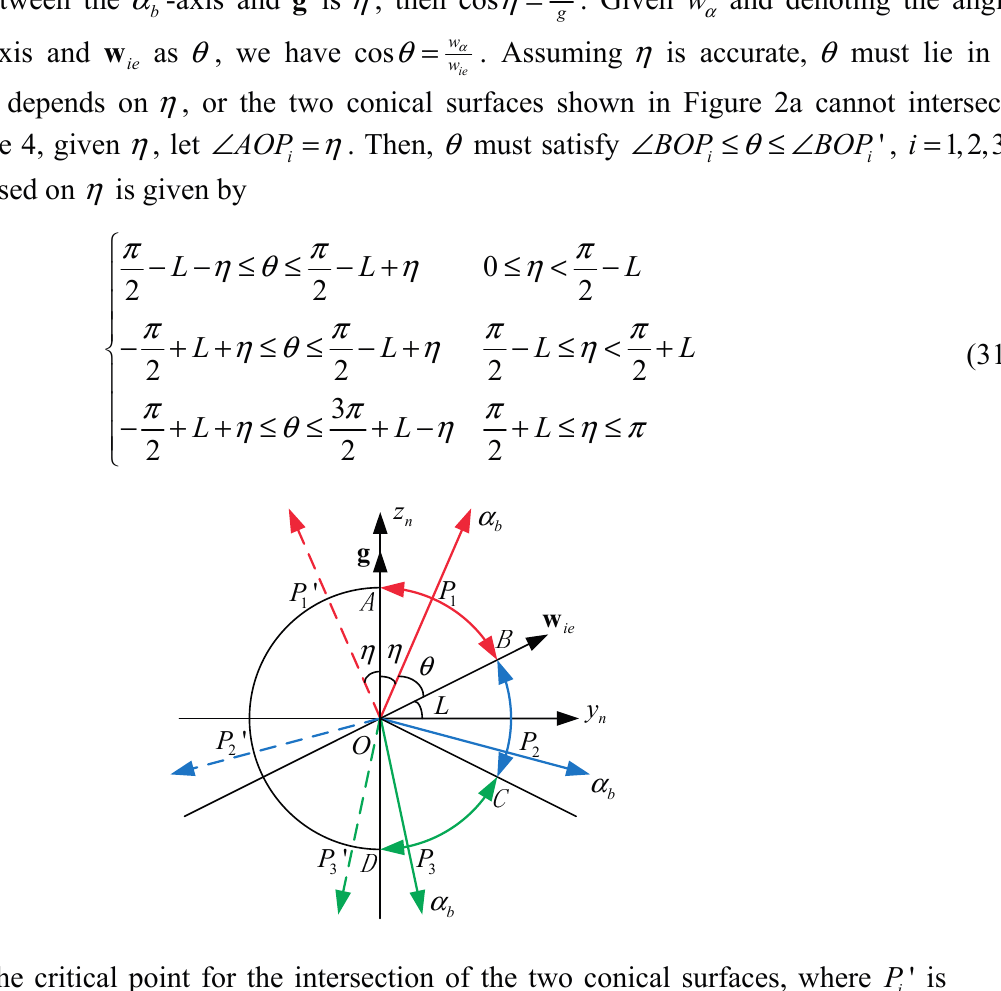
, must be as a function of f , where the point ( ) f w α α α α